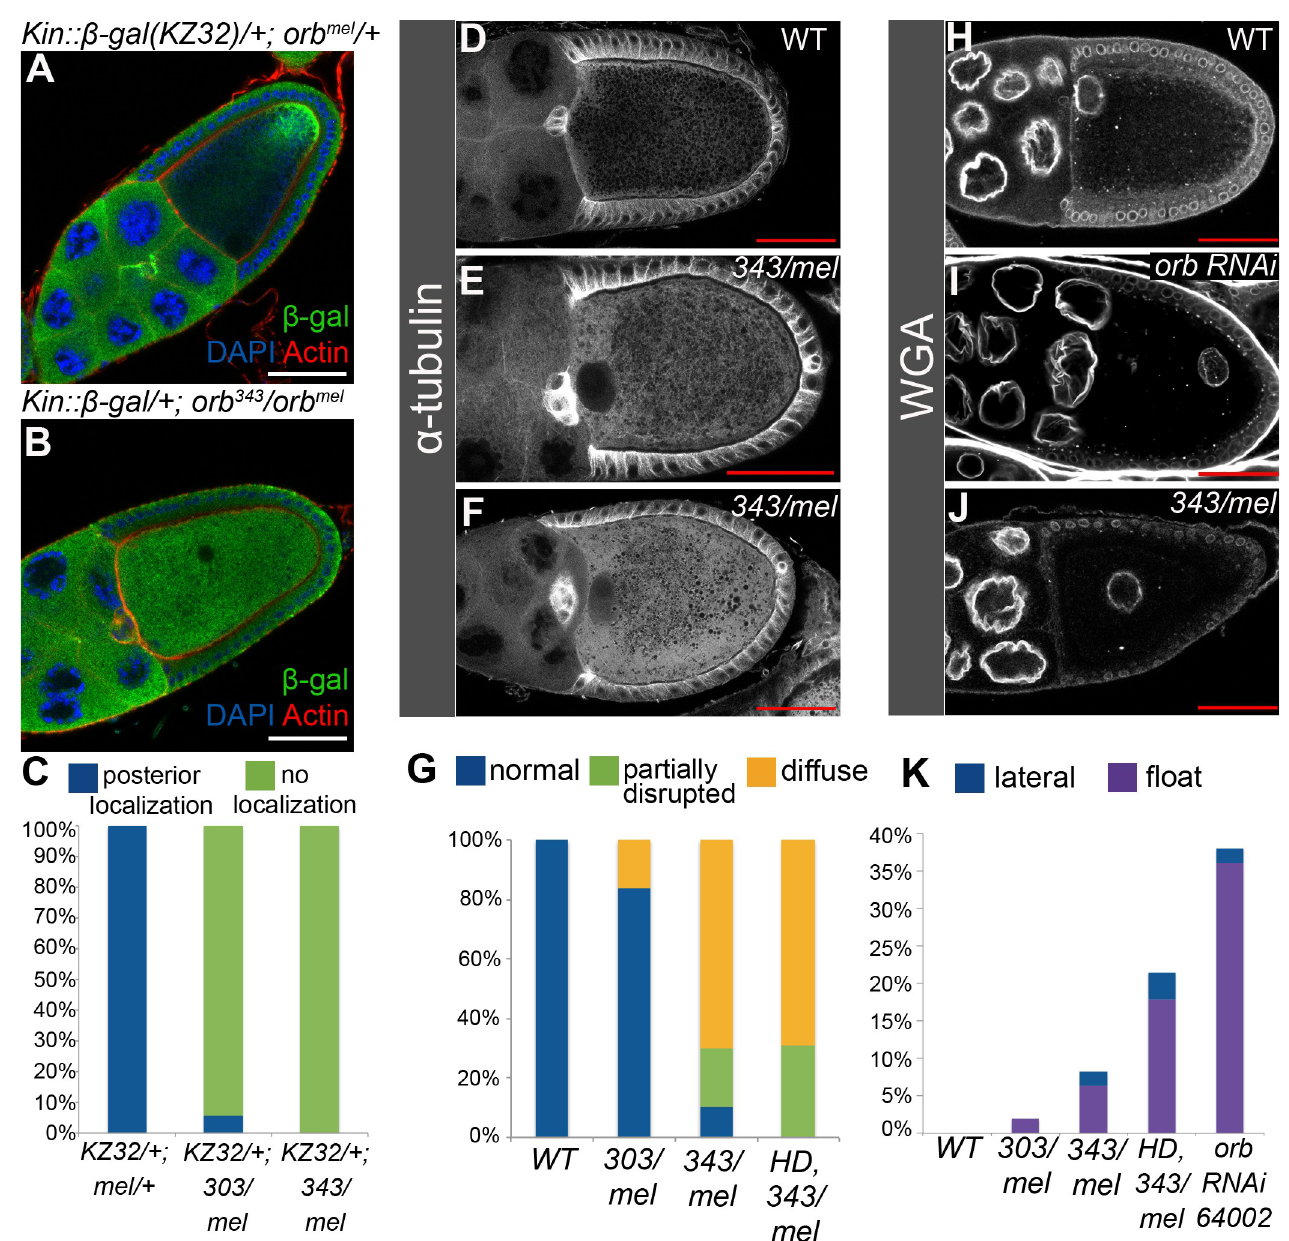
Fig 3. orb mutants have defects in microtubule organization and in positioning the oocyte nucleus. (A) Kinesin- β gal (encoded by KZ32 ) is enriched at the posterior of a stage 10 oocyte in an orb mel heterozygous background. (B) Kin- β gal does not localize to the posterior at stage 10 in orb 343/mel . (C) Frequency of posterior enrichment of Kin- β gal in orb mel heterozygotes (n = 52), orb 303/mel (n = 35) and orb 343/mel (n = 41). (D) α -tubulin is enriched in subcortical bundles in a wild type stage 10 oocyte. (E) A 343/mel stage 10 oocyte in which the α -tubulin bundles are partially displaced from the cortex, and considerable faction of the α -tubulin is distributed throughout the oocyte. (F) A 343/mel stage 10 oocyte in which α -tubulin is diffuse throughout the oocyte. (G) Quantification of defects in subcortical α -tubulin organization at stages 9–10 wild type (n = 17), 303/mel (n = 37), 343/mel (n = 20) and HD , 343/mel (n = 29) oocytes. (H) Wheat germ agglutinin (WGA) staining of wild type shows that the oocyte nucleus is positioned at the dorsal anterior corner. (I) In orb RNAi (64002) driven by maternal α - tubulin Gal4 (7062) the oocyte nucleus is not correctly positioned. (J) 343/mel also shows defects in the position of the oocyte nucleus. (K) Quantification of defects in oocyte nucleus position at stages 10–11 in wild type (n = 60), 303/mel (n = 102), 343/mel (n = 110), HD , 343/mel (n = 84) and orb RNAi (64002) driven by α -tubulin Gal4 (7062) (n = 50). All scale bars in Fig 3 are 50 microns.